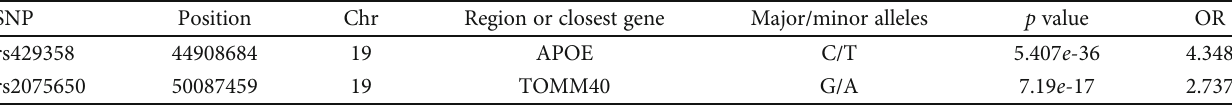
Table 2: SNP summaries reaching genome-wide signi fi cance after GWAS.